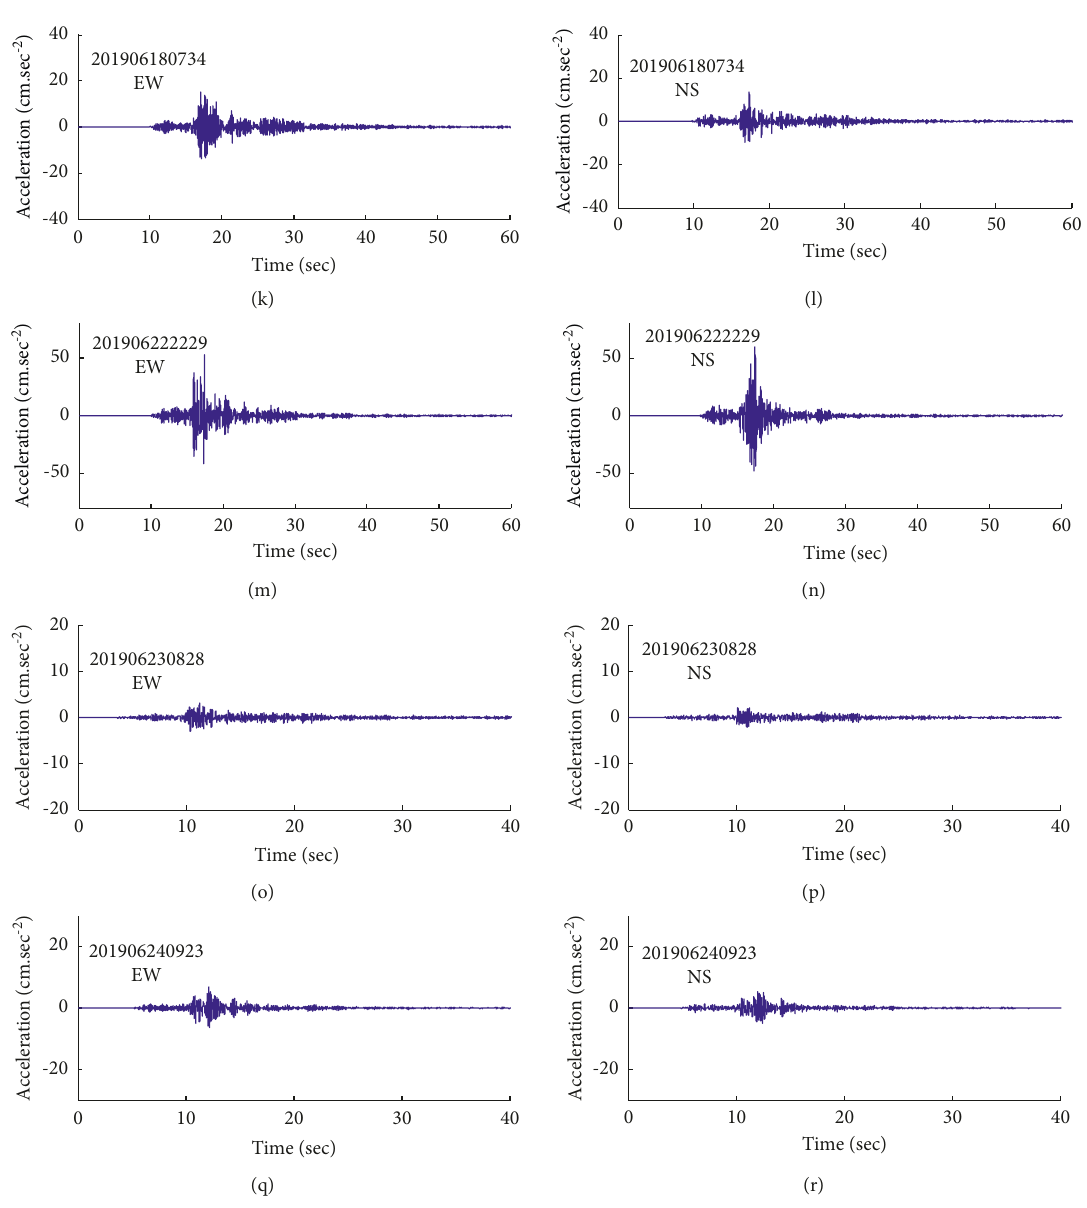
Figure 3: The horizontal strong-motion seismograms for nine earthquakes at the station